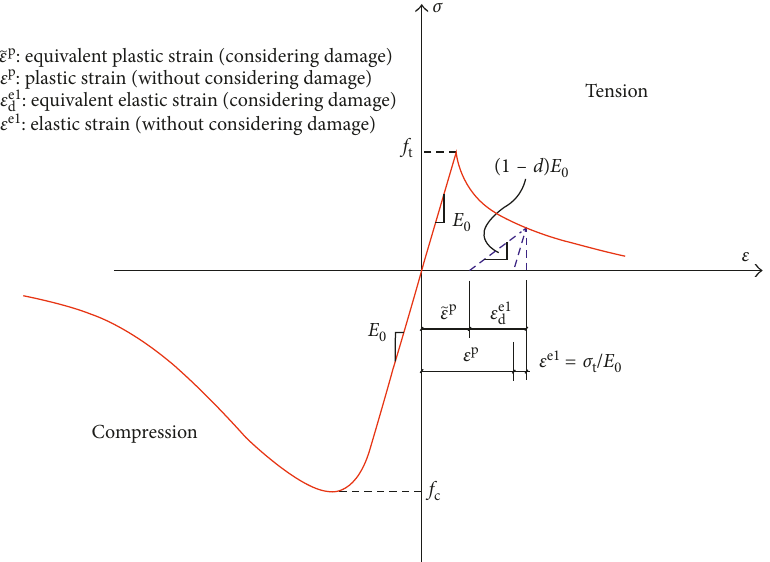
Figure 4: Uniaxial mechanical behavior of concrete and the damage